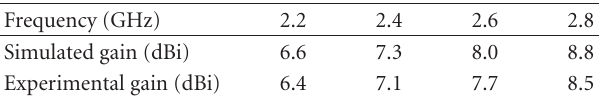
Figure 10: Simulated and experimental reflection coe ffi cient results of the proposed Yagi-Uda antenna array. Table 2: The simulated and experimental results of the printed Yagi-Uda antenna array